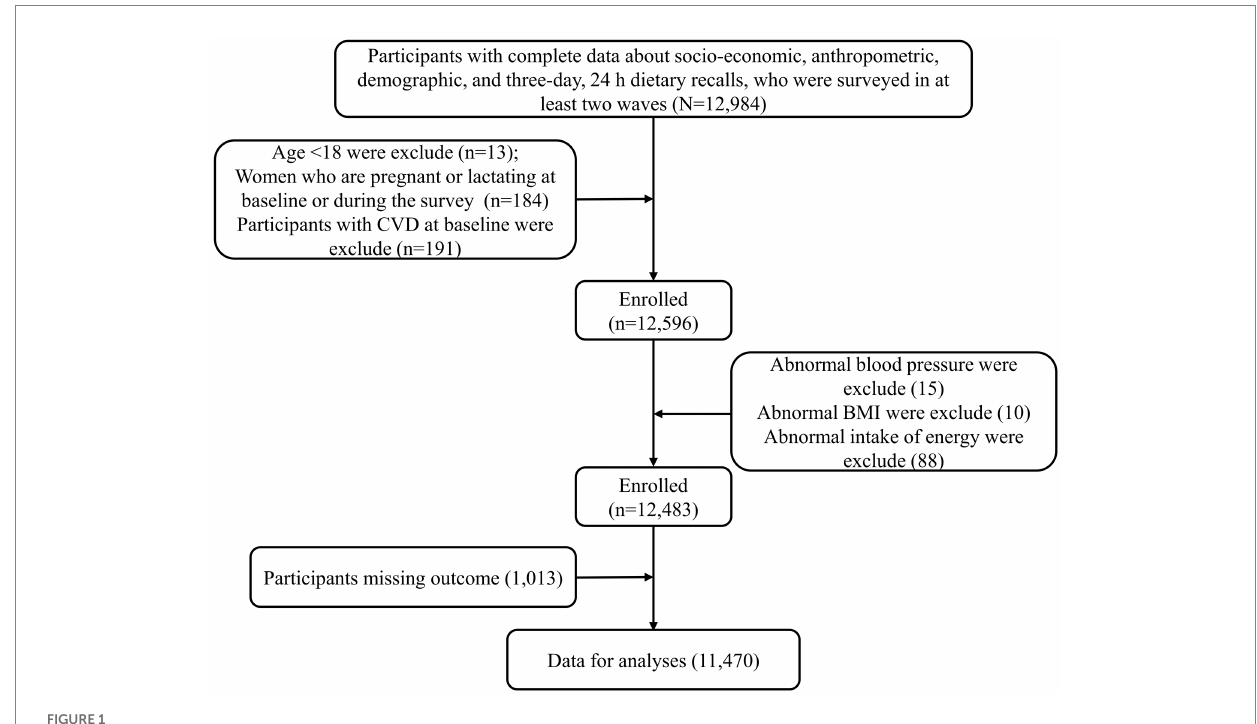
FIGURE 1 Study flow